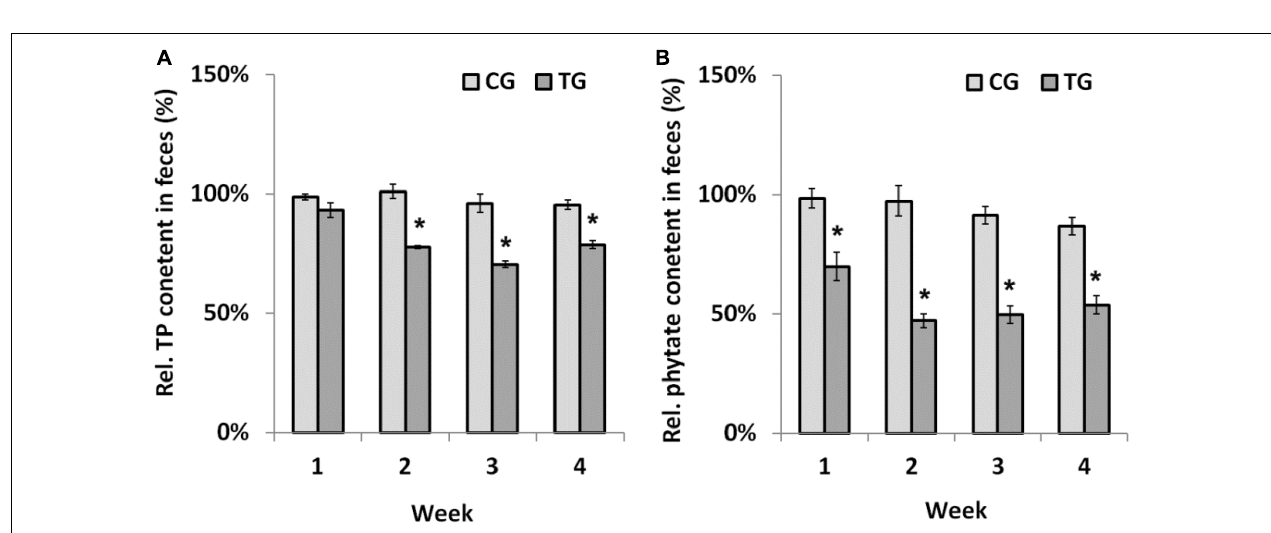
FIGURE 4 | Phytate degradation by B. longum JCM 1217/pBPES-tu in chicks. (A) relative TP contents in the feces of chicks collected from different groups at each weekend; (B) relative remnant phytate in the feces of chicks collected from different groups at each weekend. Data are mean ± SD of three samples collected from three cages relative to the corresponding contents in NG group. Statistical analysis was performed using one-way ANOVA with Bonferroni post-test ( ∗ significant with P < 0.01). NG, non-treat group; CG, control group; TG, test group.